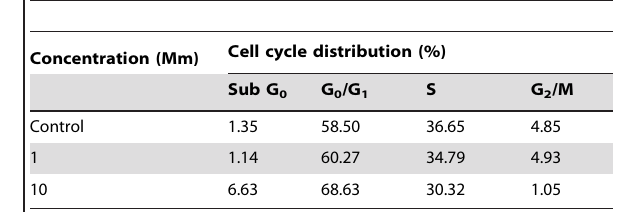
Table 5. Effect of 12a on MCF-7 cell cycle